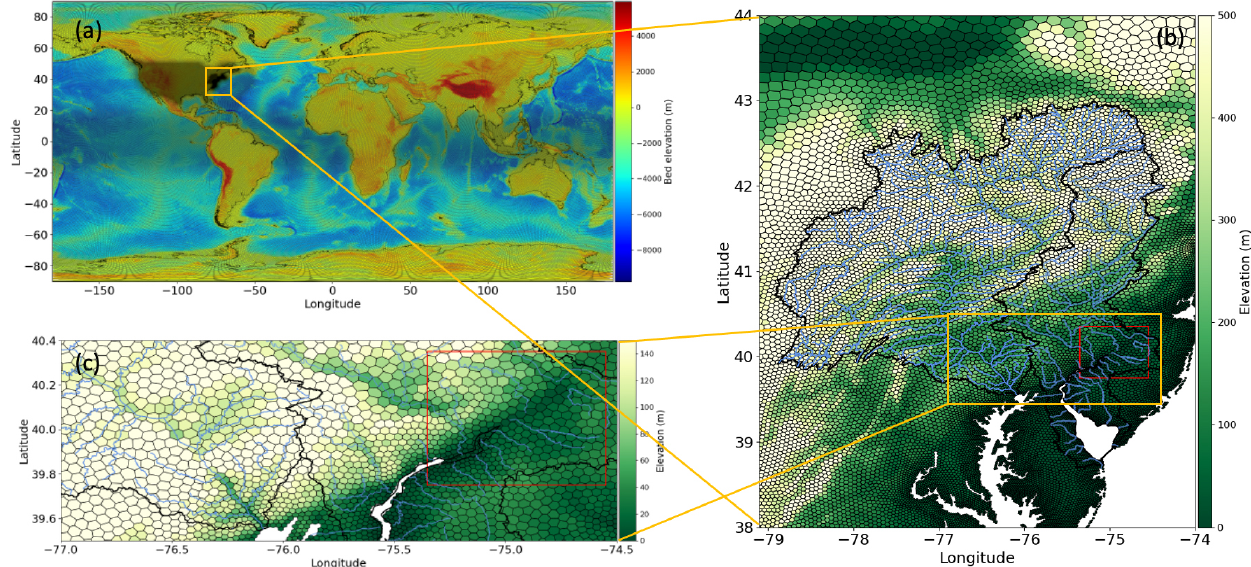
Figure 2. (a) The global unstructured mesh of E3SM. (b) A magnified view of the mid-Atlantic region (orange square in a ). (c) A magnified view near the mouths of the Susquehanna River and Delaware River (orange rectangle in b ). The red rectangles in (b) and (c) represent the downstream section of the Delaware River used for backwater propagation